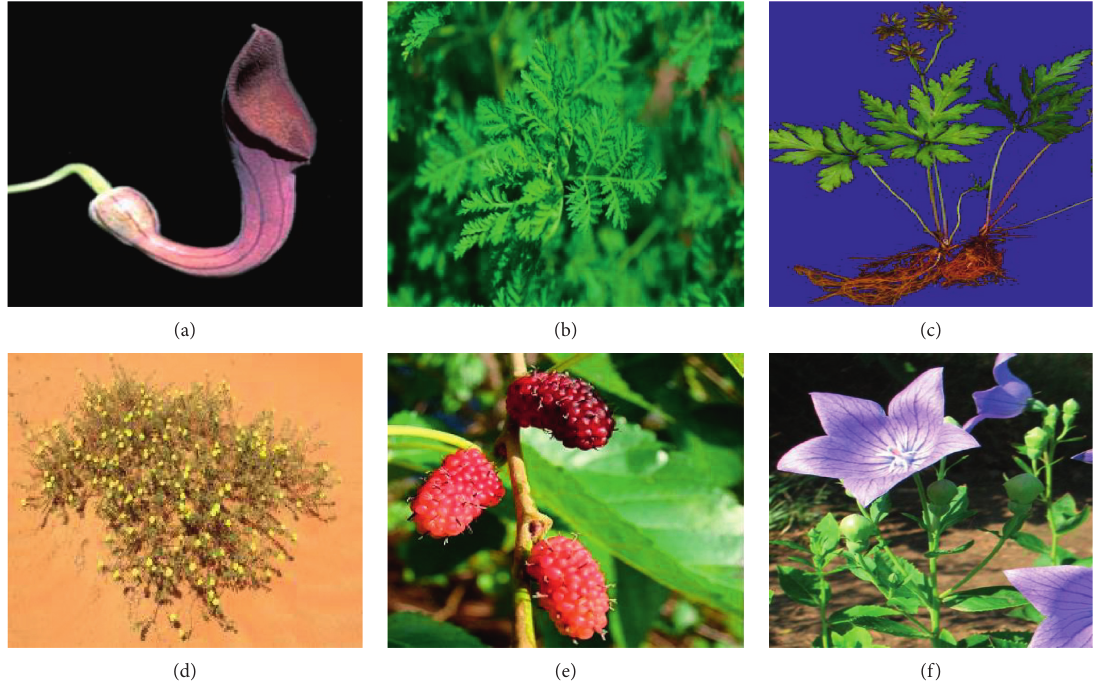
Figure 1: Plants under review with anticancer activities. (a) Aristolochia baetica , adopted with permission from [9], (b) Artemisia annua , adopted with permission from [10], (c) Coptidis rhizome , adopted with permission from [11], (d) Fagonia indica , adopted with permission from [12], (e) Morus alba , adopted with permission from [13], (f) Platycodon grandifloras , adopted with permission from